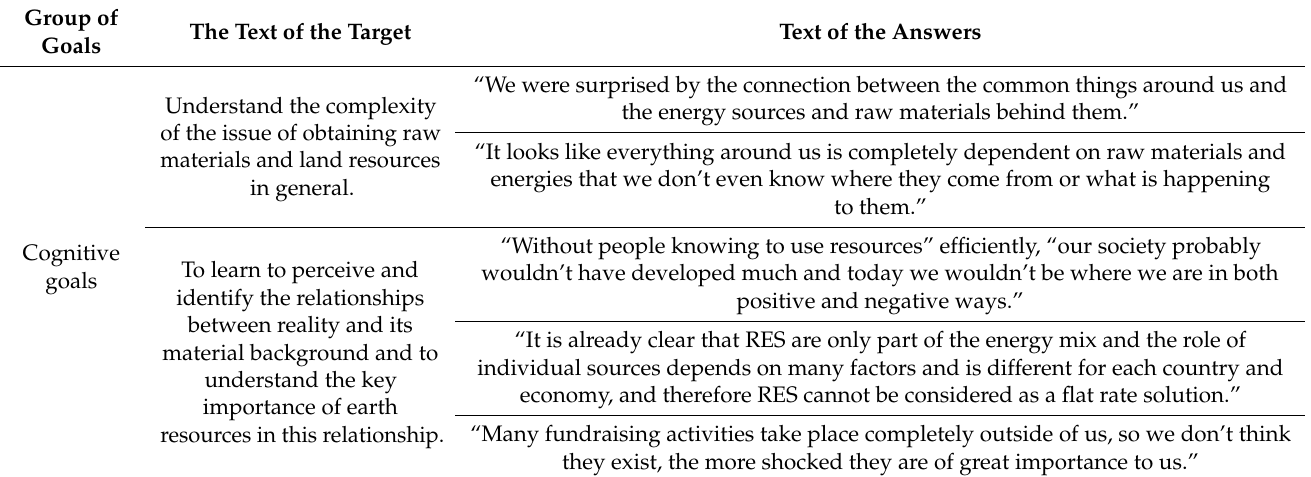
Table 1. Citation of answers obtained in the framework of the implementation of the feedback to the first